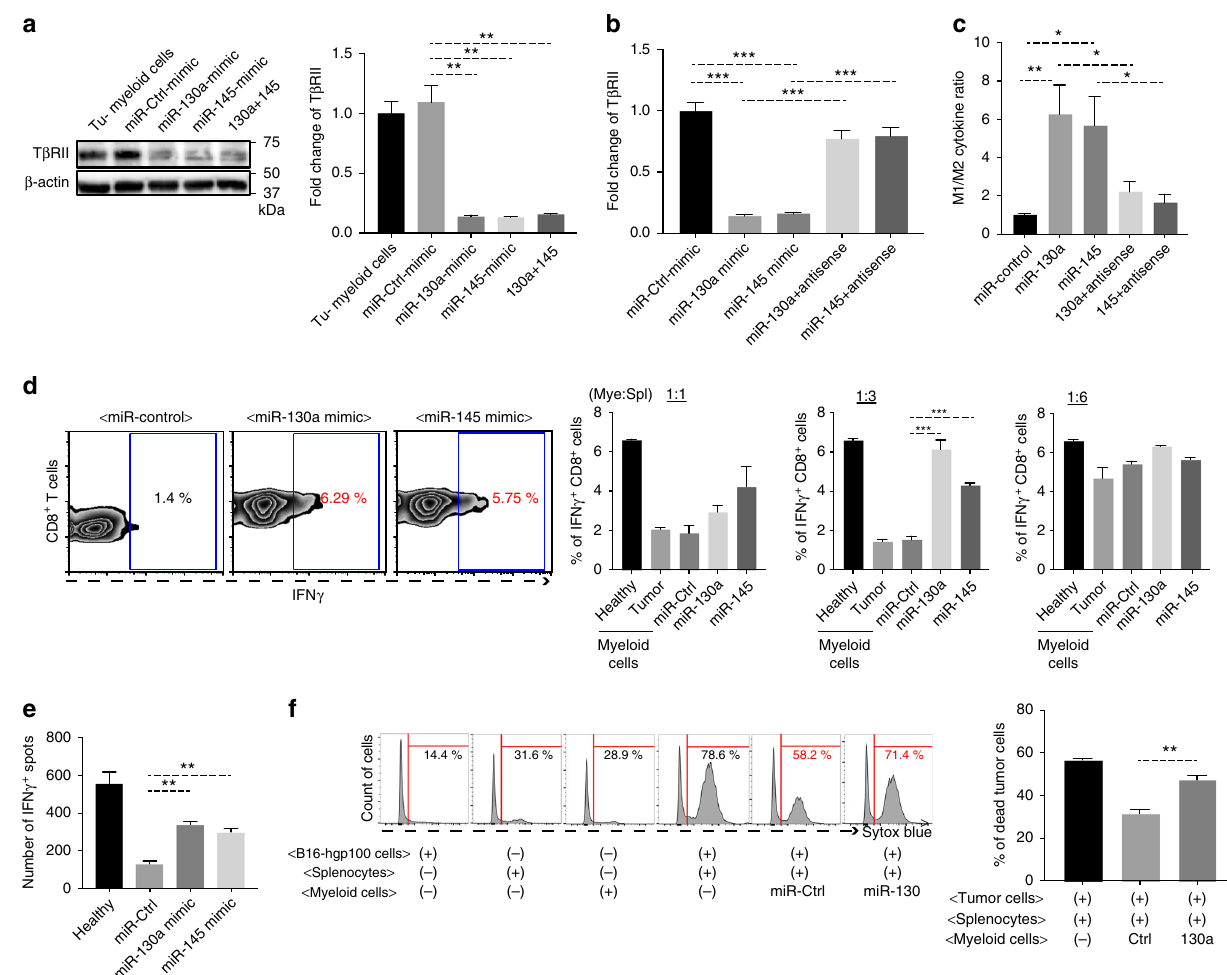
Fig. 4 miR-130a & miR-145 reprogram Gr-1 + CD11b + cells and enhance host immunity. a T β RII Western blot (left) and qRT-PCR (right) of Gr-1 + CD11b + cells from 4T1 tumor-bearing mice 24 h after miR control, miR-130a and miR-145 electroporation. b qRT-PCR of T β RII after electroporation of miR-130a or miR-145 with or without miRNA antisense inhibitors. c M1/M2 cytokine ratio post treatment with miRNA electroporation with or without miR-130a or miR- 145 antisense inhibitors ( n = 5). The ratio of M1/M2 cytokines was calculated by dividing each M1 cytokine (TNF α , IL-12, GM-CSF) to M2 cytokine (IL-10, TGF β 1, IL-4) as described in Material and Methods. d Left panels: fl ow cytometry of IFN γ + CD8 + T cells from splenocytes of TCR-HA transgenic mice co- cultured with Gr-1 + CD11b + myeloid cells with or without miRNA, which were pulsed with HA peptide. Right panels: quantitative data. The Gr-1 + CD11b + cells (Mye) to splenocytes (Spl) ratio is indicated for each panel. e IFN γ ELISPOT of splenocytes from TCR-HA transgenic mice co-cultured with Gr-1 + CD11b + cells following miRNA electroporation. f CTL assays: fl ow cytometry of B16 melanoma tumor cells (Sytox blue positive are dead) expressing hgp100 co-cultured with splenocytes from Pmel-1 transgenic mice and Gr-1 + CD11b + cells from spleens of miR-130a transgenic, quantitative data on right. The percentage of targeted dead tumor cells = total dead cells + subtraction of dead cells from a single culture of tumor cells, myeloid cells, and splenocytes. All data are presented as mean±SEM, and Student ’ s t test was performed. * p < 0.05, ** p < 0.01, *** p <